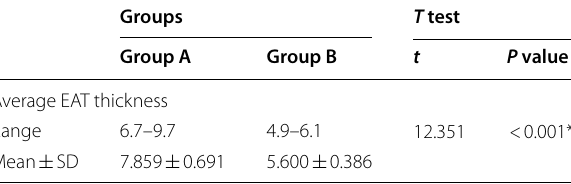
EAT epicardial adipose tissue thickness, SD standard deviation * Significant